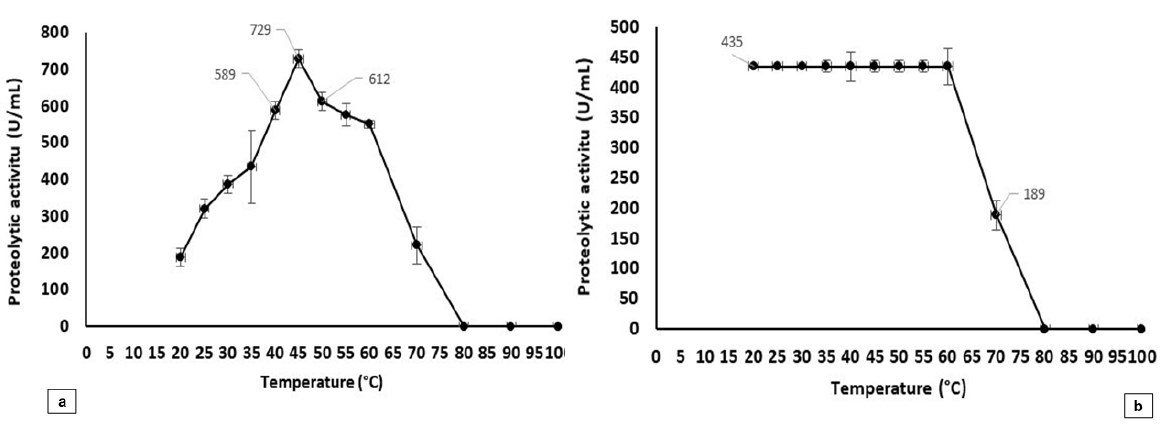
Figure 6. Optimum temperature (a) and temperature stability (b) assays to evaluate the activity of the purified enzyme obtained from Aspergillus sydowii URM5774 . Protease assays were carried out using purified protease (0.75μg). Error bars represent the standard deviation of triplicate measurements.